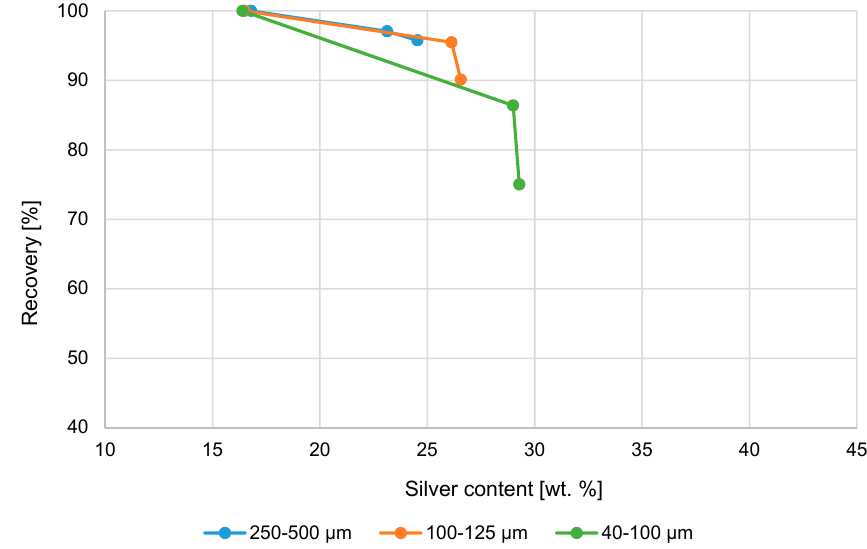
Figure 7. Cumulative silver recovery (%) and Ag-content (wt. %) in product using electrostatic separation.